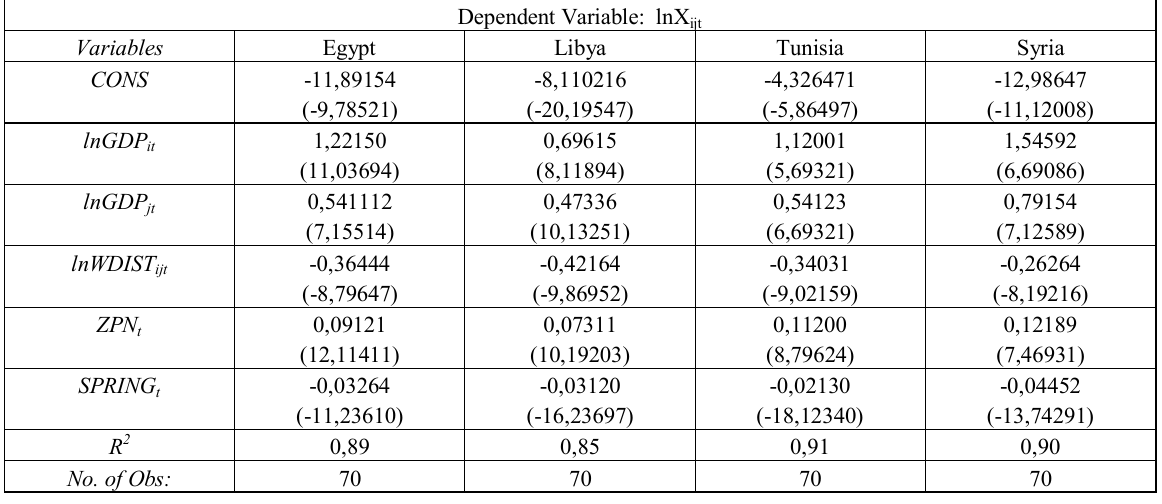
Table 2A: Estimation Results for Export Side